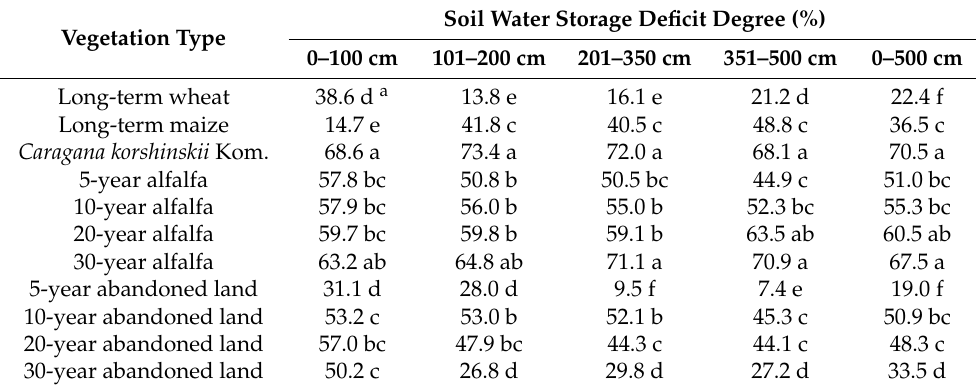
Table 3. Effect of land use on soil water storage deficit degree in different soil layers. Vegetation